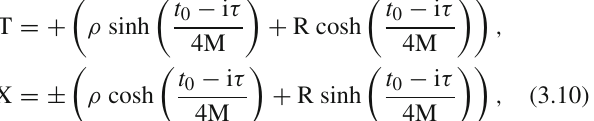
− T 2 = ( r 0 − 1 ) e r0 = − R 2 , at the 2M 1 1 2M